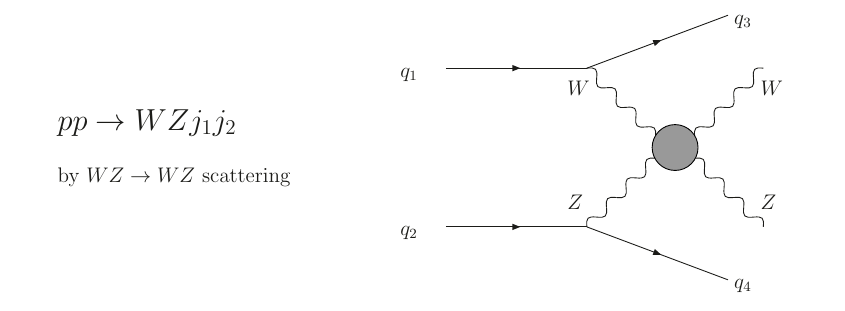
Figure 10 . Graphical representation of the pp WZjj process at the LHC, at the parton level, ! by means of WZ WZ scattering. The initial W and Z gauge bosons are radiated from the ! constituents quarks of the protons and are generically virtual particles which re-scatter to produce the (cid:12)nal W and Z